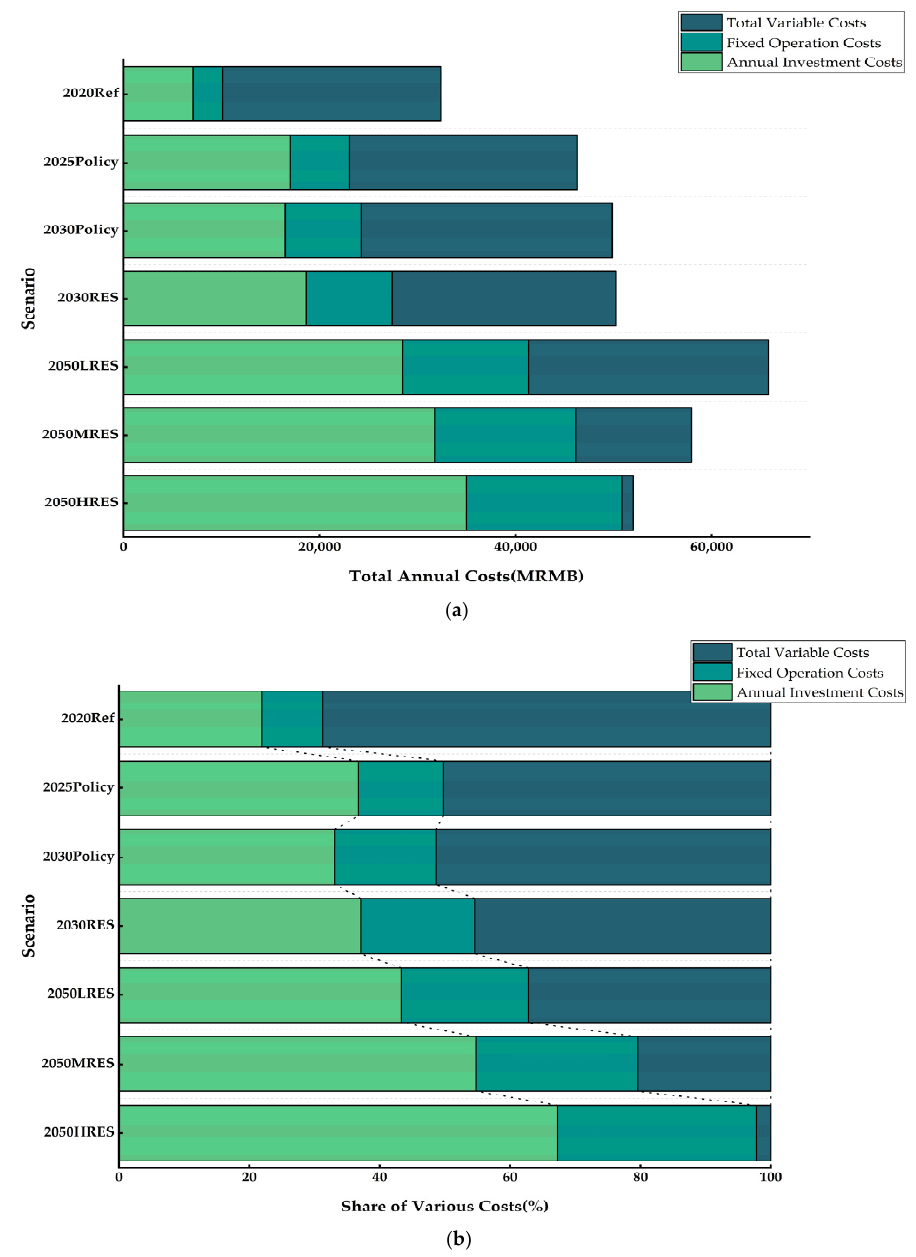
Figure 6. ( a ) The detailed simulation results of the energy system’s total annual costs in the seven scenarios. ( b ) Changes in the share of each category in the seven scenarios.